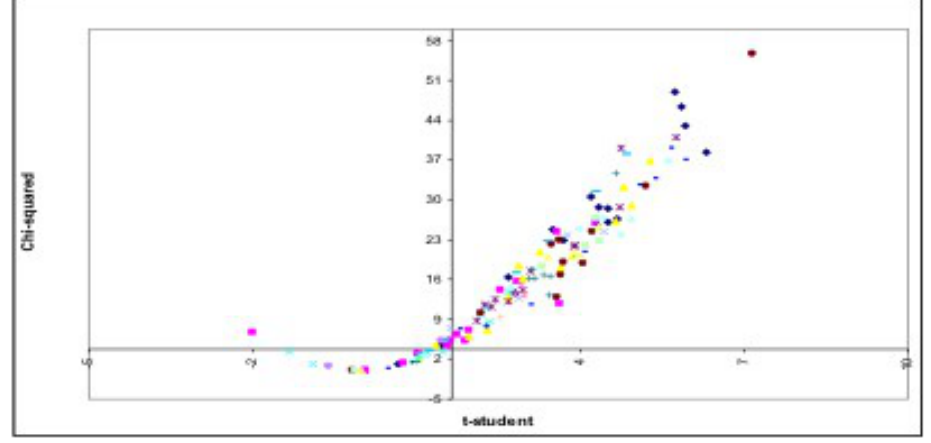
Figure 1. t-ratio and  2 (Eurostat)